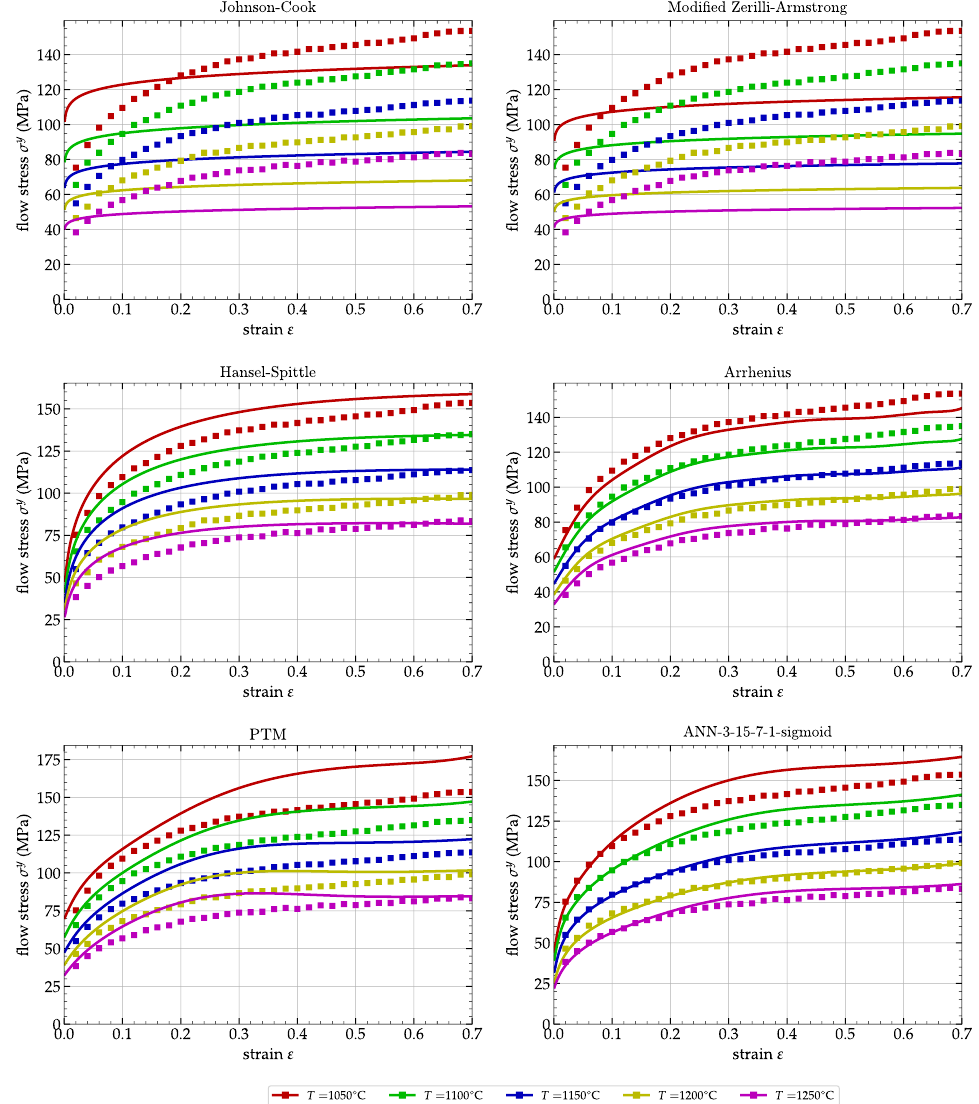
Figure 15. Comparison between the experimental (dots) and predicted (lines) flow stresses σ y for . ε = 5 s − 1